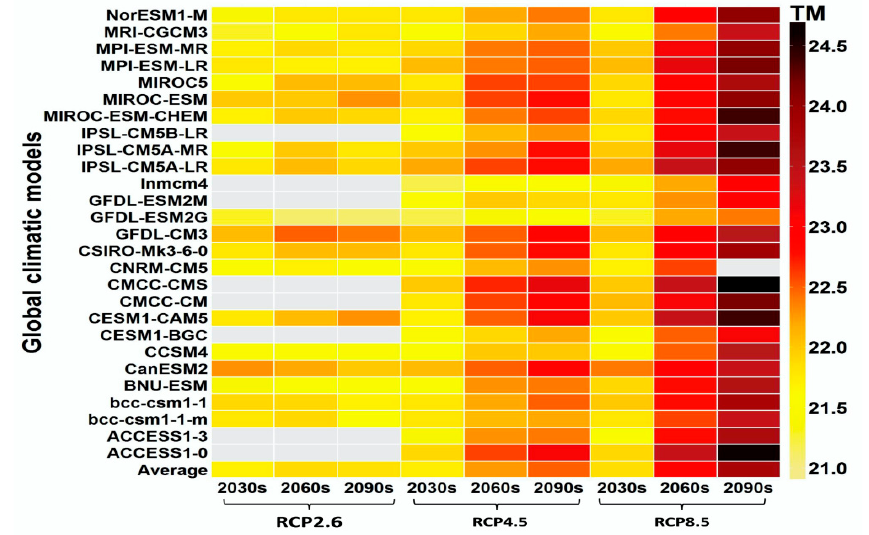
Figure 1. Annual temperature in the 2030s, 2060s, and 2090s under different climatic models and RCP scenarios. Gray grids mean that the data were not available.